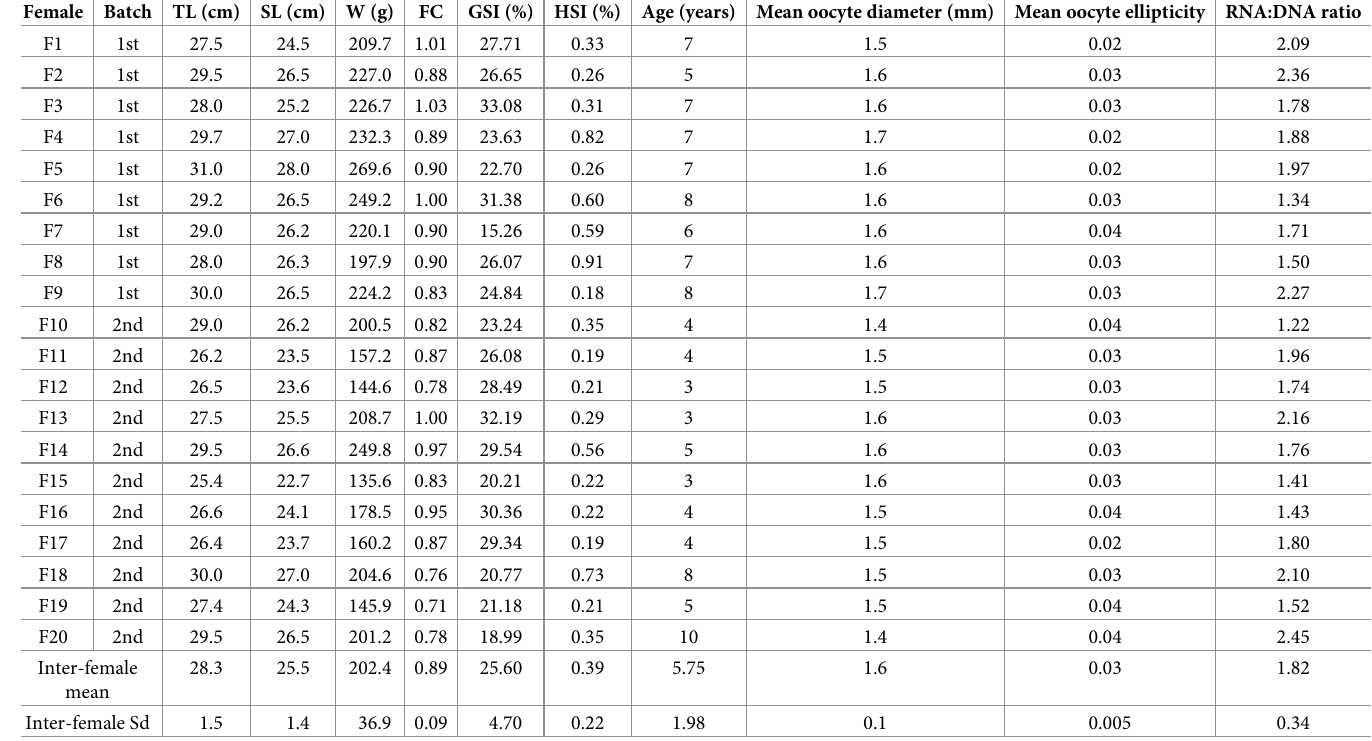
Table 3. Traits measured for the different Downs herring ( Clupea harengus ) females. TL: Total Length; SL: Standard Length; W: Wet weight; FC: Fulton Condition index; GSI: Gonadosomatic index; HSI: Hepatosomatic index; sd: standard